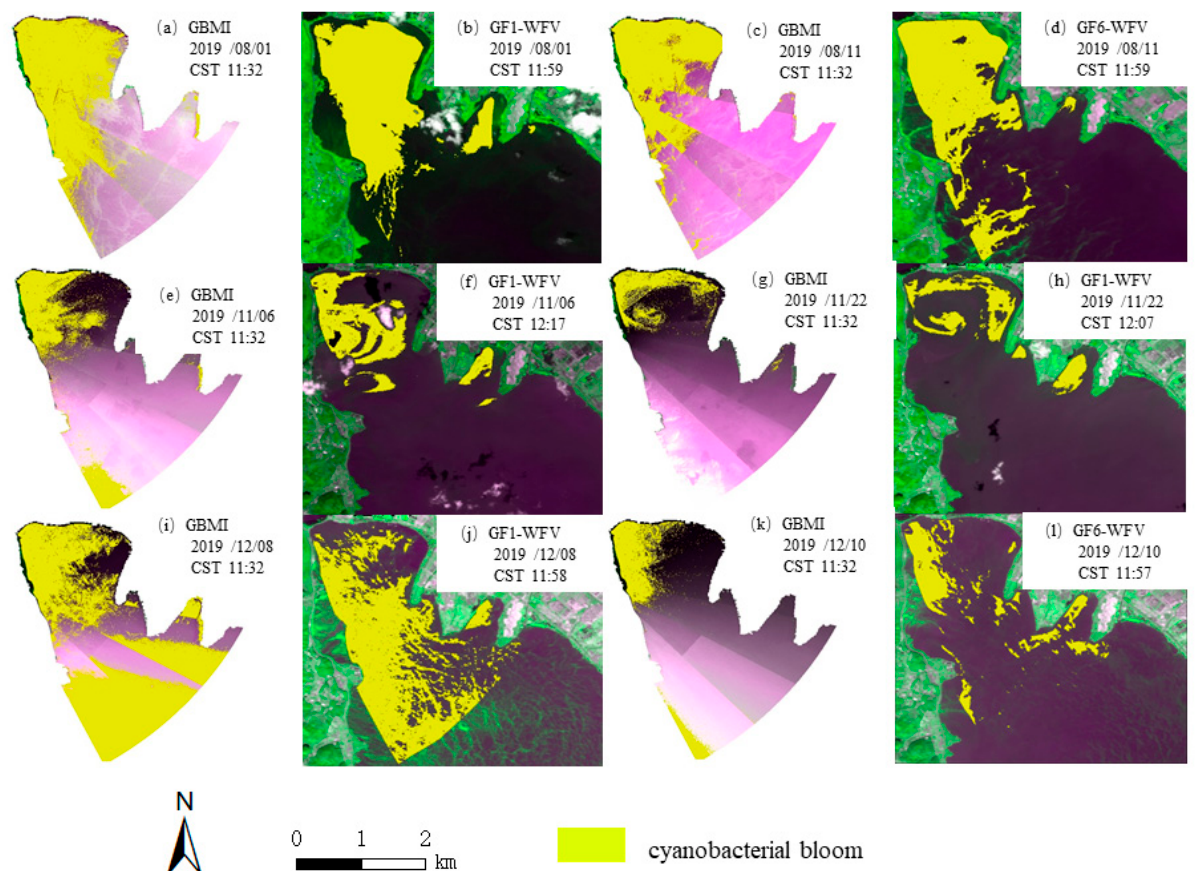
Figure 4. Comparison of extraction results of cyanobacteria bloom in Dianchi Lake from synchronous GF satellite and ground-based multispectral images (GBMI).